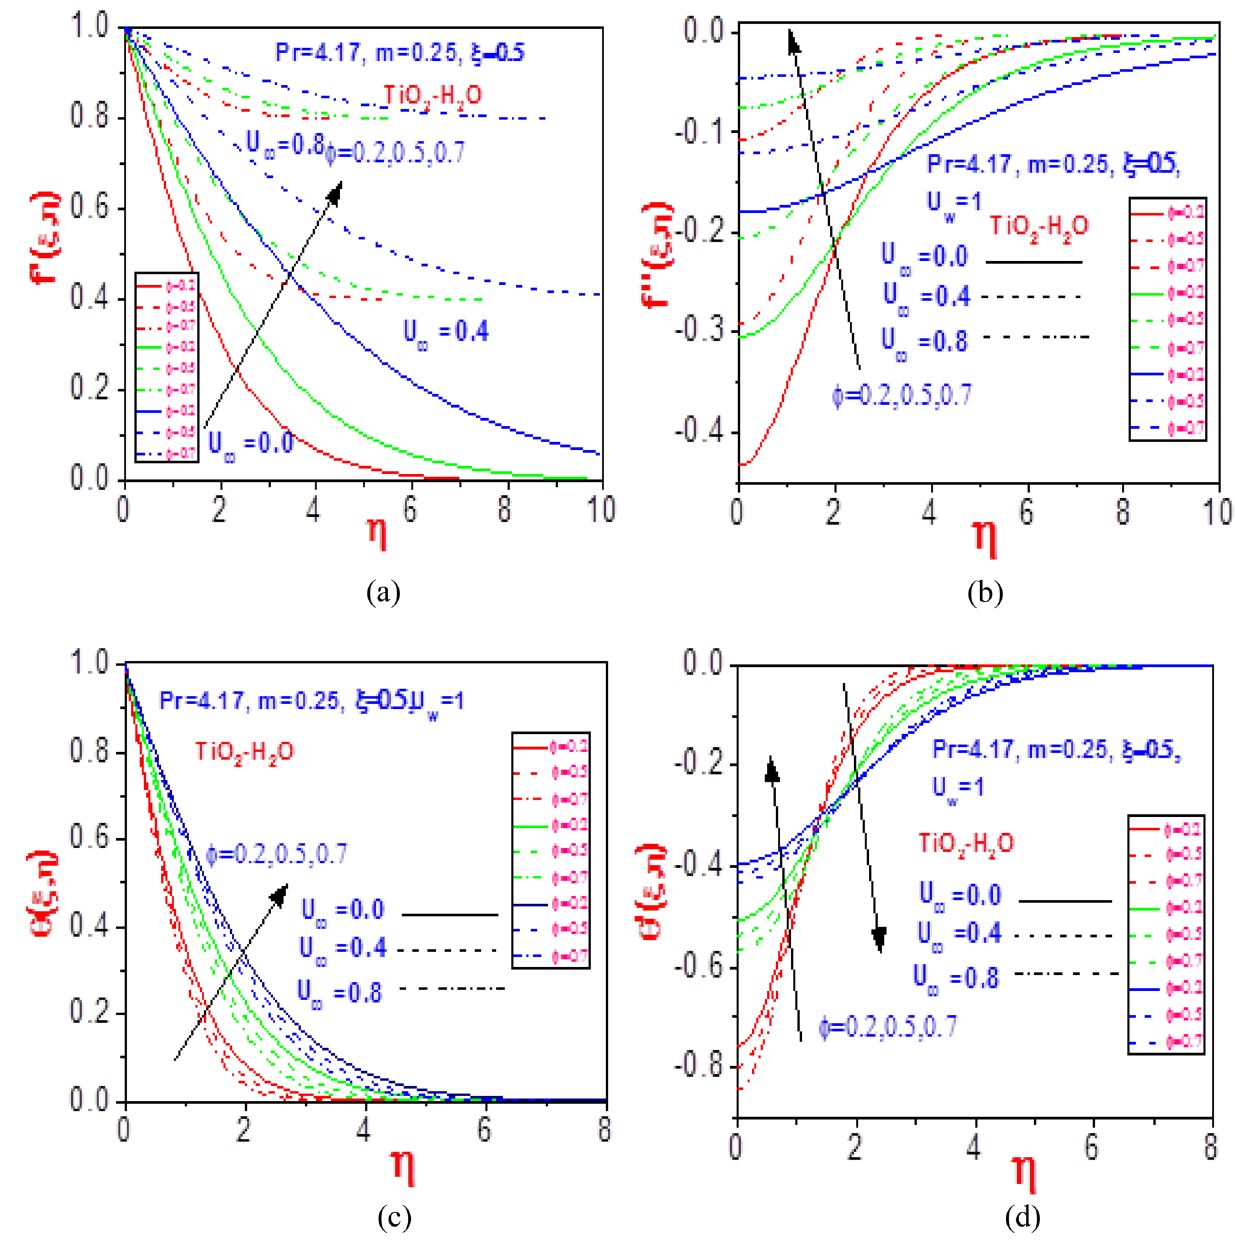
Figure 8. Profiles of ( a ) velocity f ′ (ξ , η) , ( b ) missing velocity slope f ′′ (ξ , η) , ( c ) temperature θ(ξ , η) , and ( d ) missing temperature slope θ ′ (ξ , η) with different values of U ∞ and φ for Ti 2 O 2 -H 2